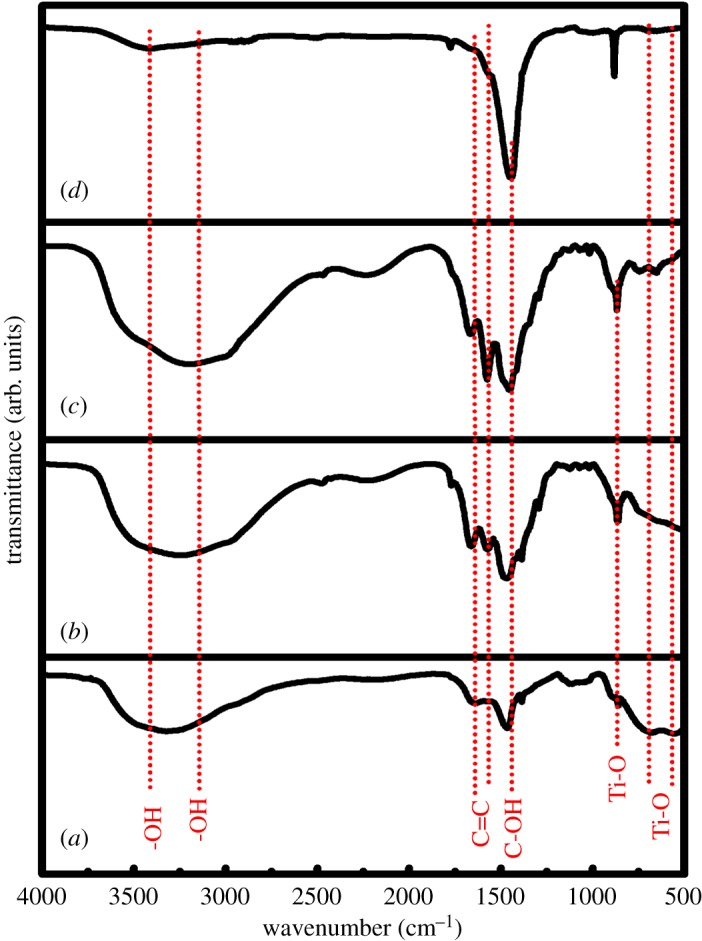
FTIR spectra of (a) r-GO, (b) TiO2, (c) TiO2: Sr, and (d) TiO2: Sr/r-GO.